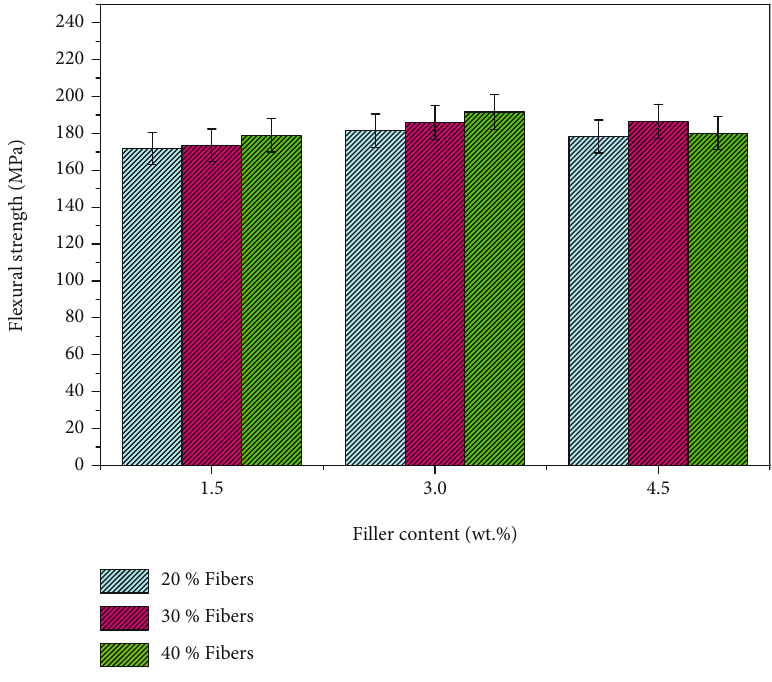
Figure 6: Flexural strength of nanocomposites with di ff erent fi ller and fi bre content.